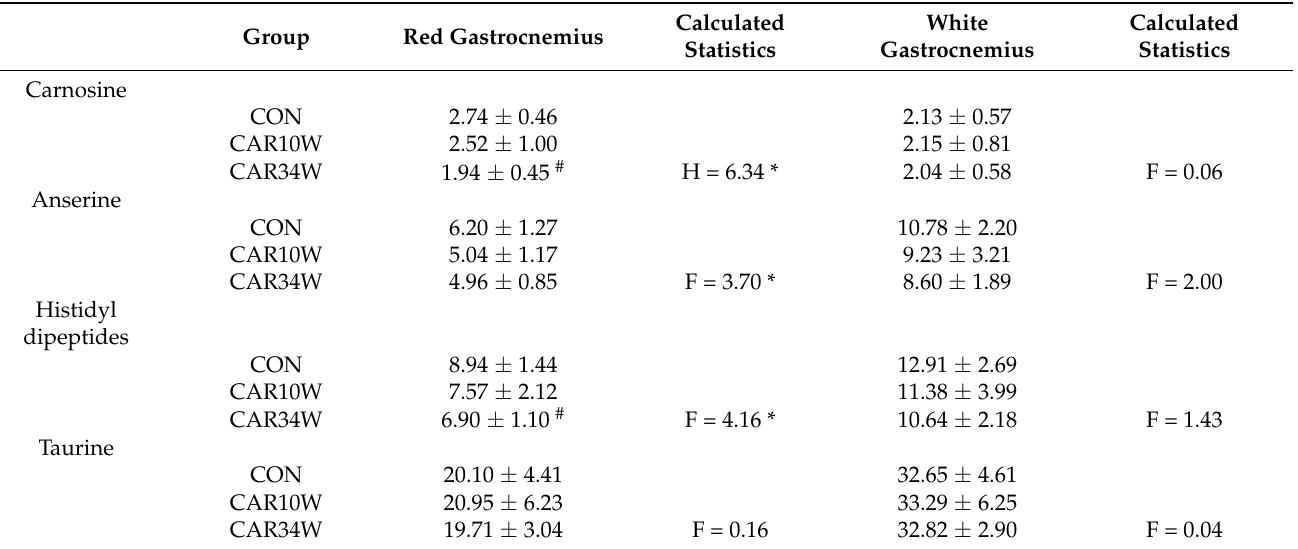
Table 3. Muscle concentrations of carnosine, anserine, histidyl dipeptides (the sum of carnosine and anserine), and taurine (mmol/kg